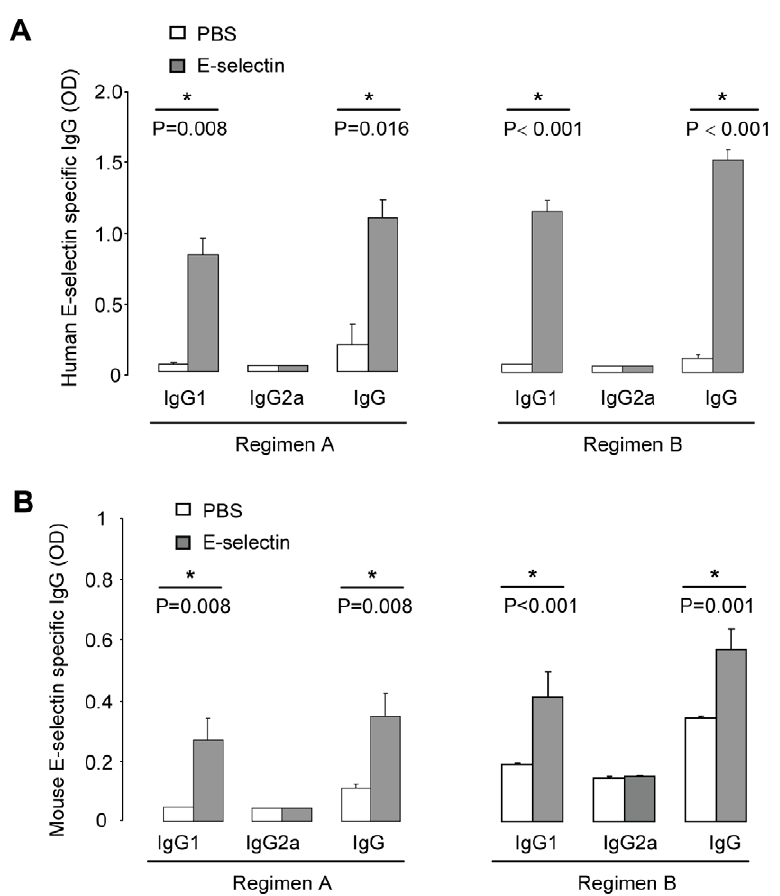
Figure 5. Serum E-selectin specific antibodies. Serum was collected after 7 weeks on a high-fat diet. (A) Human E-selectin specific IgG1, IgG2a and total IgG in mice on regimen A (N=5 per group) or regimen B (N=24 for PBS group, N=23 for E-selectin group). (B) Mouse E-selectin specific IgG1, IgG2a and total IgG in mice on regimen A (N=5 per group) or regimen B (N=24 for PBS group, N=23 for E-selectin group).